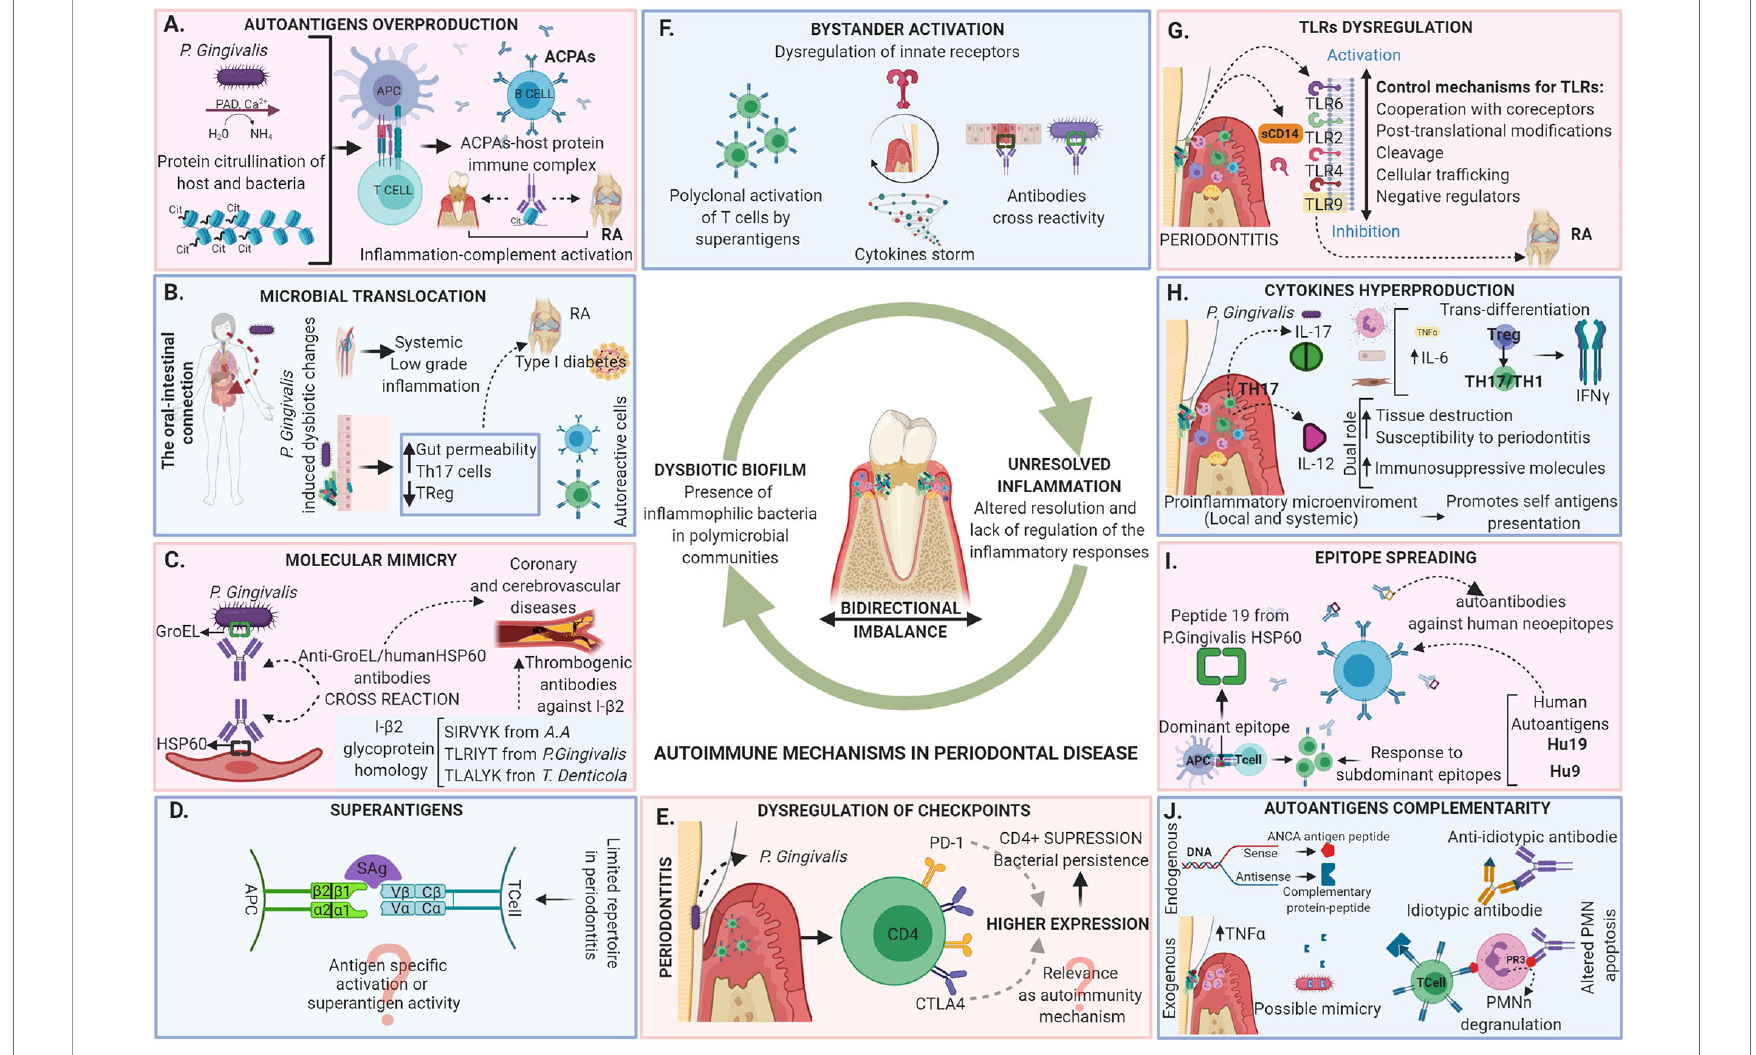
FIGURE 1 | Autoimmune mechanisms in periodontal disease. Periodontitis is today described as the result of dysbiosis of the oral microbiota guided by in fl ammophilic bacteria, leading to an altered resolution of in fl ammation and a lack of regulation of the in fl ammatory response. The tissue damage in periodontitis is directly related to the activation of in fl ammatory mechanisms by the host that are in a bidirectional imbalance with the microbiome. The dysregulation leads to the appearance of local and systemic autoimmune responses mediated by different mechanisms including (A) Autoantigens overproduction, (B) Microbial translocation, (C) Molecular mimicry, (D) Superantigens, (E) Dysregulation of checkpoints, (F) Bystander activation, (G) TLRs dysregulation, (H) Cytokines hyperproduction, (I) Epitope spreading and (J) Autoantigens complementarity. The evidence of the activation of the diverse autoimmune mechanisms in the periodontal tissues does not necessarily indicate that they are related to local tissue damage, although they may be related to the development of autoimmune responses at the systemic level associated with the occurrence of multiple